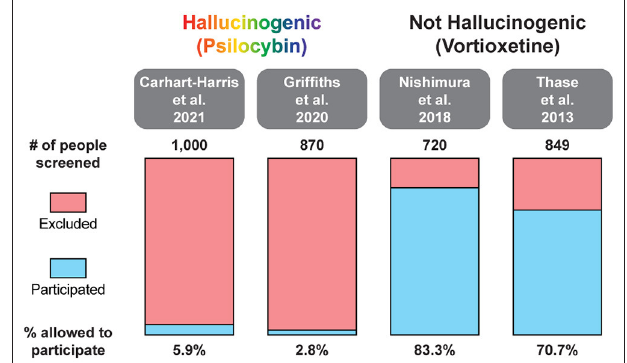
FIGURE 4 | Percentage of patients excluded from recent large MDD trials of the hallucinogenic drug psilocybin and the non-hallucinogenic drug vortioxetine. A comprehensive analysis of all psychedelic trials is beyond the scope of this review. For additional information on the broad range of smaller trials with psychedelics, please see (262,